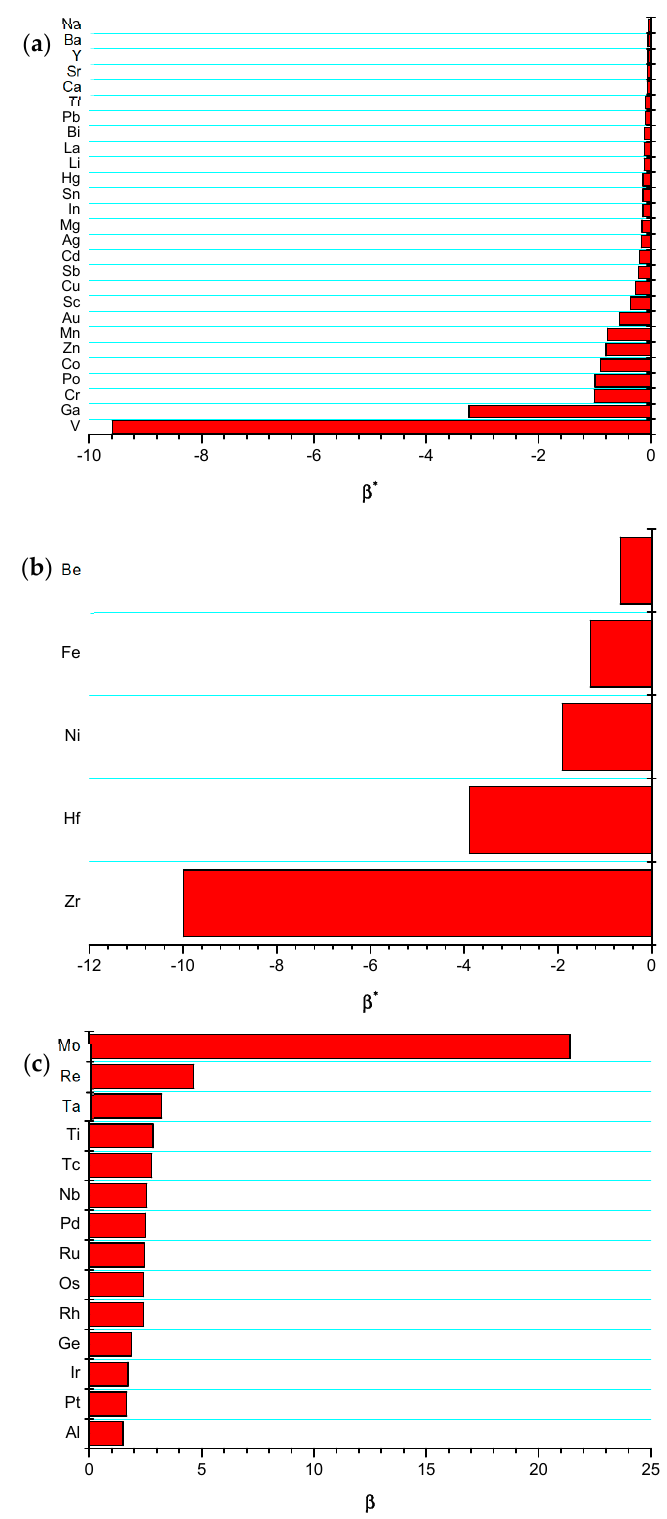
Figure 3. Value of the critical coefficient 𝛽 ∗ for W-alloys of group: ( a ) I; ( b ) II; and, ( c ) III.